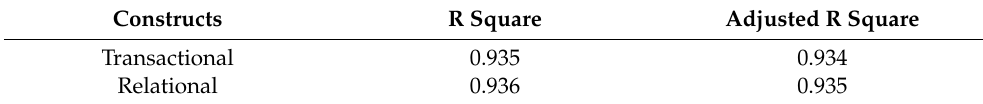
Table 4. R Square.